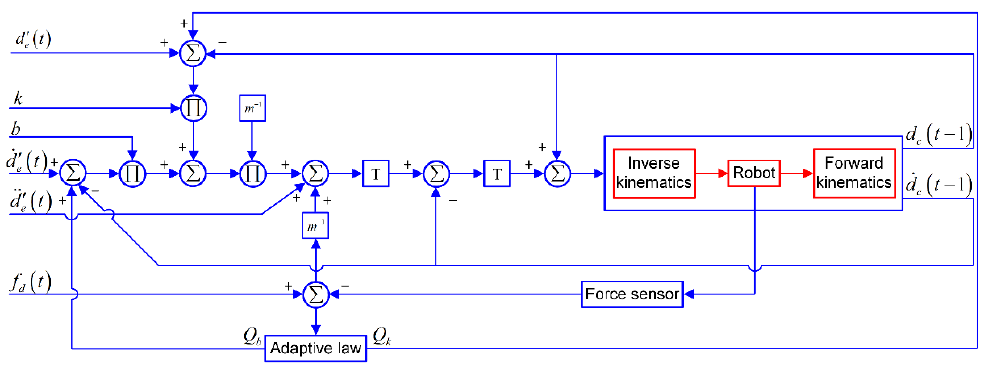
Figure 3. Adaptive impedance controller.